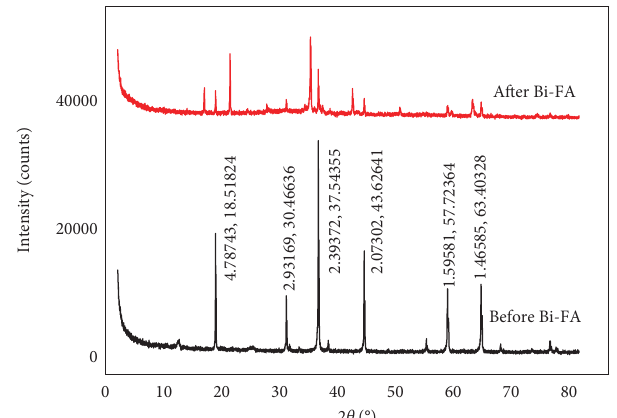
Figure 2: The X-ray powder polycrystal diffraction graph of the chromite slag after